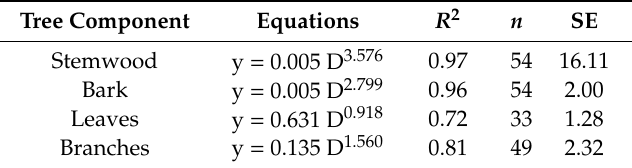
Table 3. Dry weight biomass prediction equations.